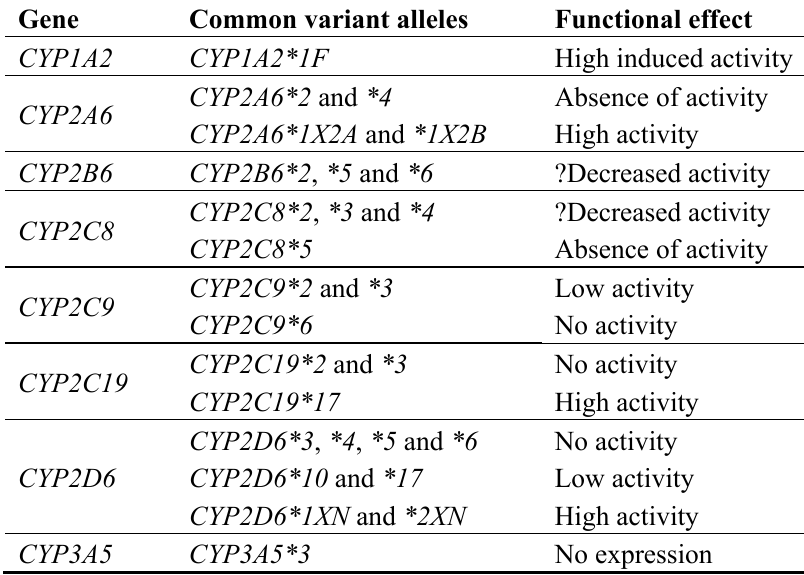
Table 2. Polymorphisms in Cytochromes P450 Relevant to Drug Metabolism and Their Functional Importance. Reproduced with permission from Daly, A.K.